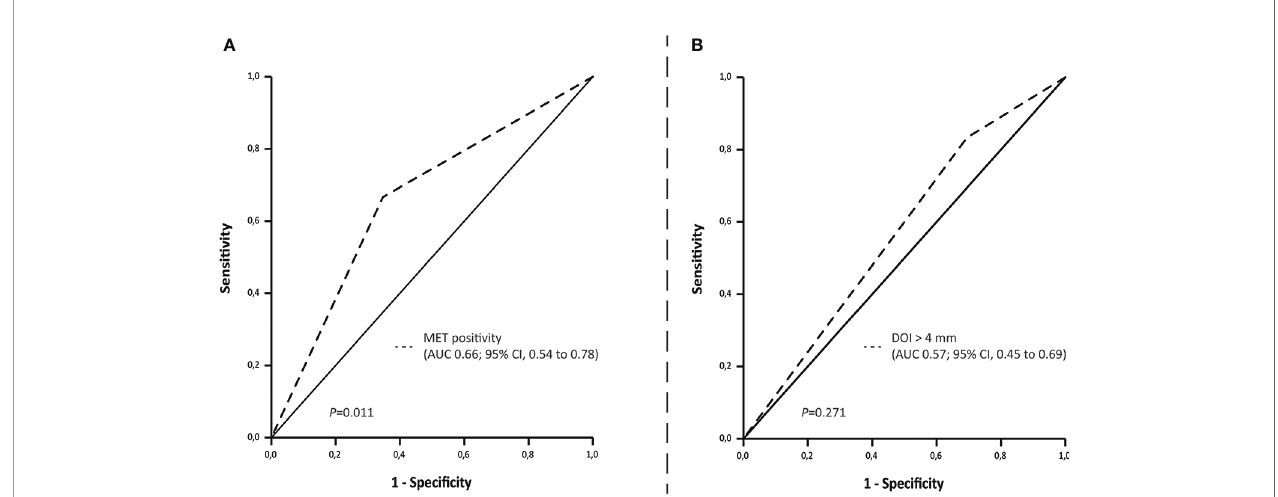
FIGURE 2 | ROC curve indicating the area under the curve for (A) MET positivity and (B) Depth of invasion set at > 4 mm and LNM (cN0 and cN+/pN+).